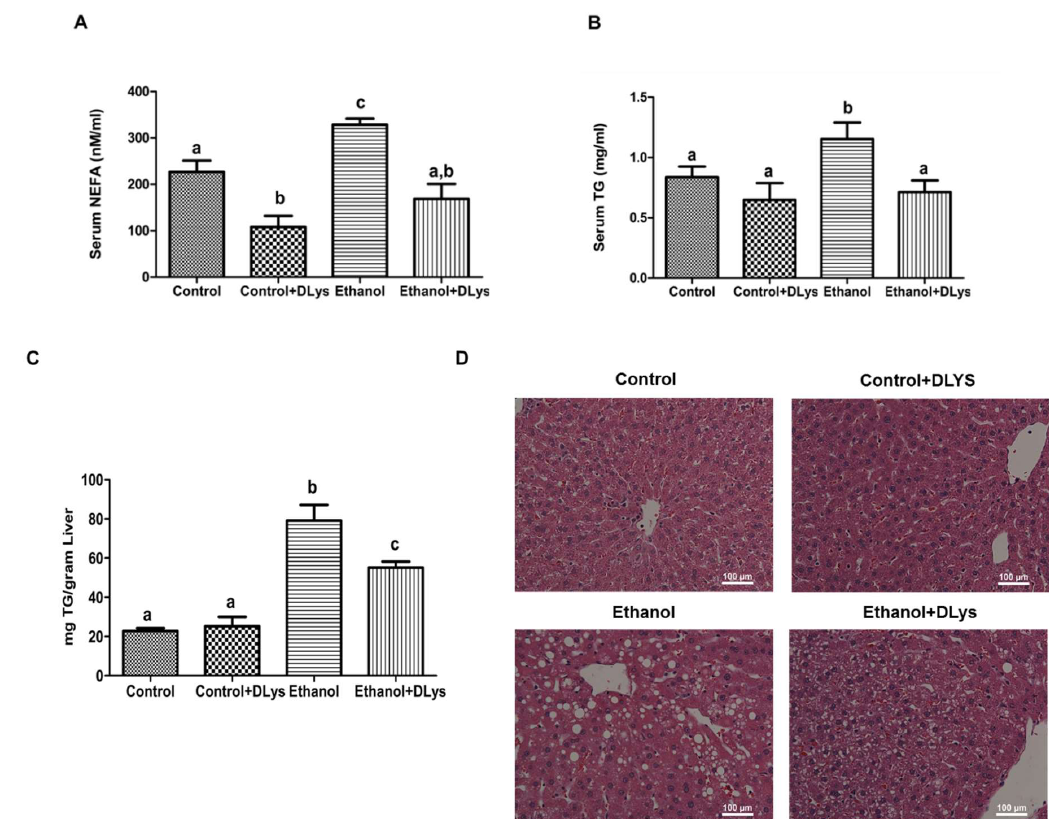
Figure 3. Serum and Hepatic Lipid Content. ( A ) Serum non-esterified free fatty acids (NEFA) levels. ( B ) Serum Triglyceride (TG) levels. ( C ) Quantitative analysis of hepatic TG content. ( D ) Hematoxylin and eosin staining of paraffin sections. Images are representative of each pair-fed group of n = 8. Magnification, 200X. Values are means ± SEM, n = 8. Values not sharing a common letter are statistically different, p ≤ 0.05.